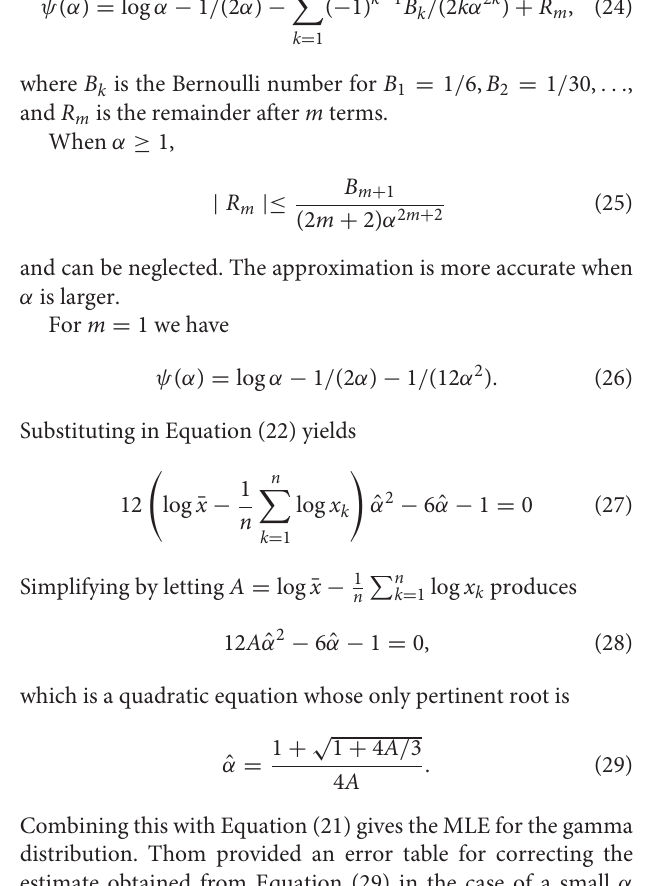
α , β ) associated with the |